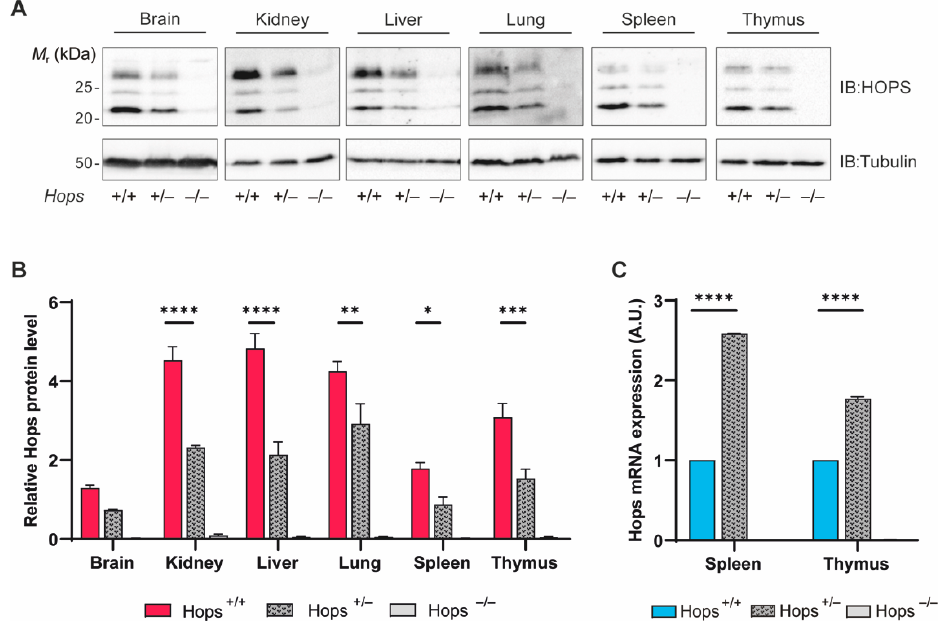
Figure 1. Baseline level of HOPS in Hops +/+ , Hops +/ − , and Hops − / − mice. ( A ) Protein extracts from Hops +/+ , Hops +/ − , and Figure 1 . Baseline level of HOPS in Hops +/+ , Hops +/– , and Hops –/– mice. ( A ) Protein extracts from Hops +/+ , Hops − / − mouse tissues were analyzed by Western blot using anti-HOPS antibody and anti- α -tubulin antibody as the loading Hops +/– , and Hops –/– mouse tissues were analyzed by Western blot using anti-HOPS antibody and control. ( B ) Densitometric analysis showed the average protein level of HOPS after normalization to the housekeeping anti- α -tubulin antibody as the loading control. ( B ) Densitometric analysis showed the average pro- protein from at least three independent experiments. Representative blots are shown. ( C ) HOPS mRNA levels were tein level of HOPS after normalization to the housekeeping protein from at least three independent quantified by RT-PCR in Hops +/+ , Hops +/ − , and Hops − / − thymus and spleen. β -actin was used as a housekeeping gene, experiments. Representative blots are shown. ( C ) HOPS mRNA levels were quantified by RT-PCR and relative Hops levels in wild-type mice tissues were assumed to be 1. Data were analyzed using two-way ANOVA with in Hops +/+ , Hops +/– , and Hops –/– thymus and spleen. β -actin was used as a housekeeping gene, and Tukey’s multiple-comparisons test. Values represent mean ± SEM. * p < 0.05, ** p < 0.01, *** p < 0.001, and **** p <